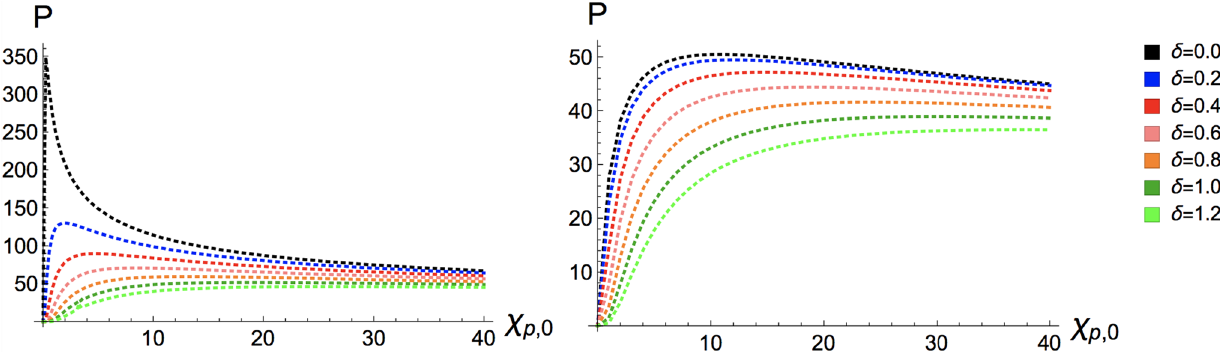
Fig. 10 The scalar (left) and pseudo-scalar (right) yields, P ± , are plotted as a function of χ p , 0 for various ALP masses, with m φ = δ m e , in a Gaussian background